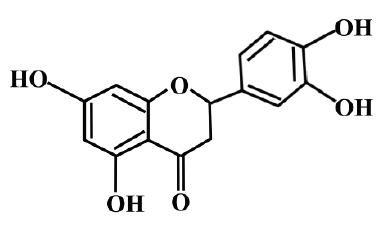
Figure 1. Chemical structures of the flavonoid eriodictyol